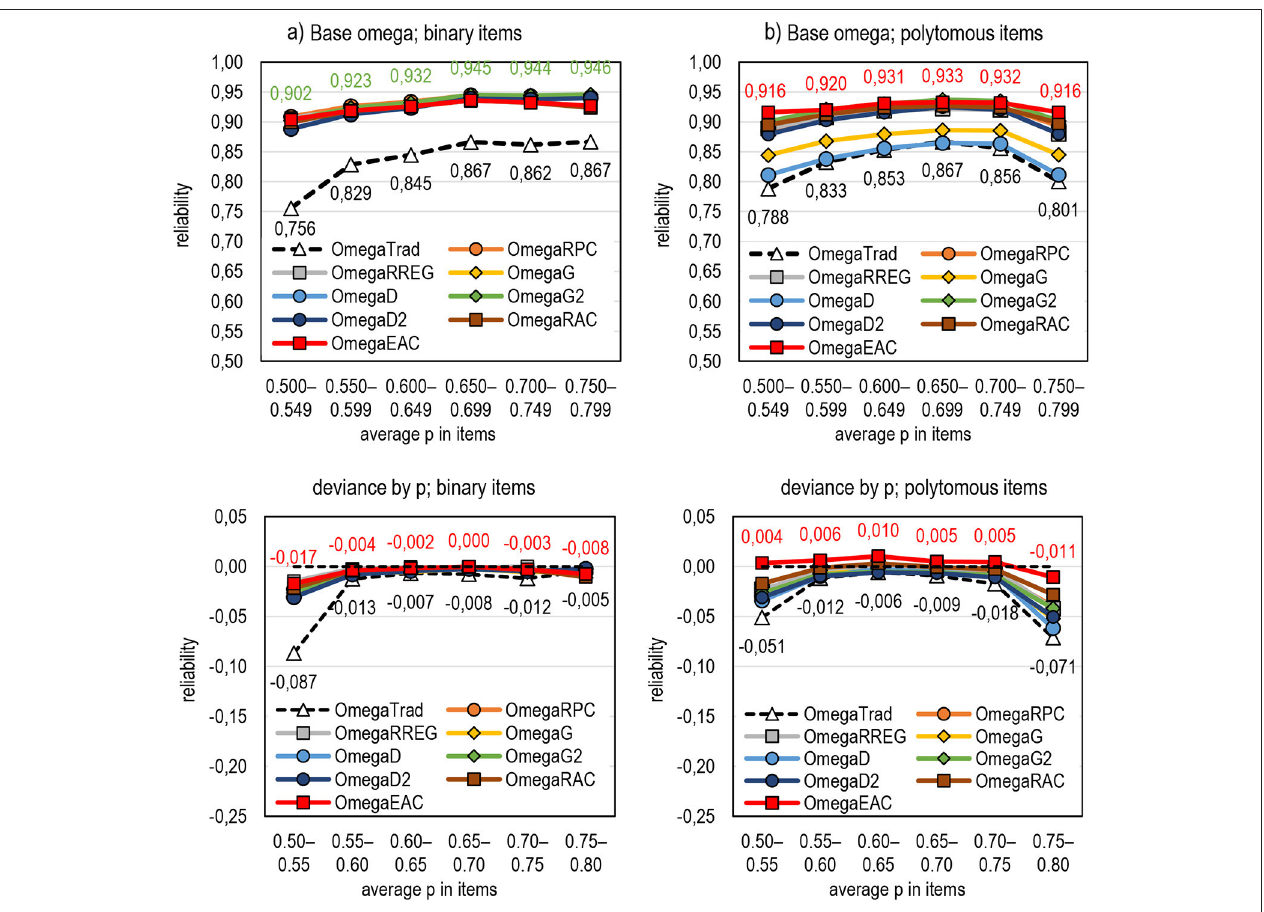
FIGURE 11 | The behavior of DCERs by test difficulty (the highest and traditional estimates are highlighted). (a) Base omega; binary items. (b) Base omega; polytomous items.